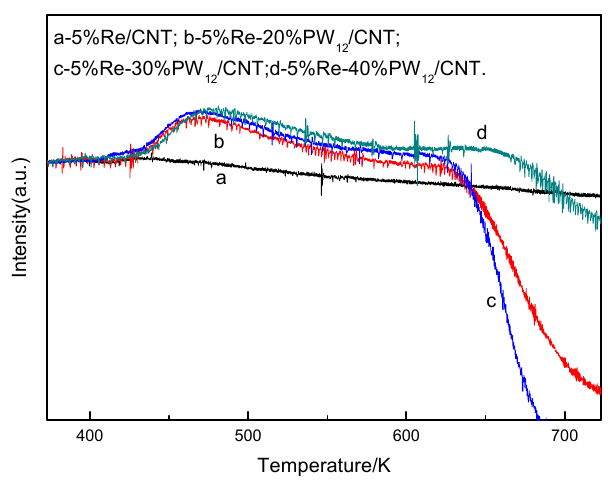
Figure 3. NH 3 ‐ TPD profiles of 5%Re ‐ PW 12 /CNTs with different PW 12 content. Table 5. Results of NH 3 ‐ TPD integration.